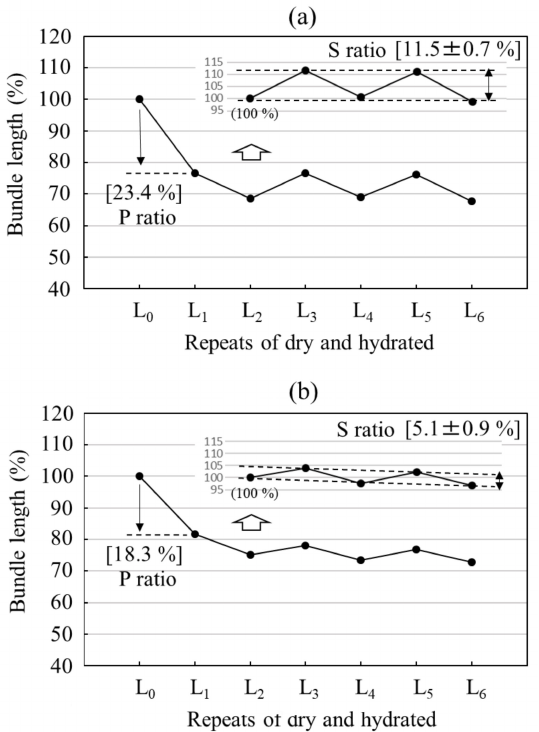
Figure 6. Dimensional stabilities of regenerated fibers of ( a ) RSSP(QQQ) and ( b ) RSSP(VLI) after repeated immersion in water. L0:L dry0, L1:L hydrated1, L2:L dry2, L3:L hydrated3 , L4:L dry4 , L5:L hydrated5 , and L6:L dry6